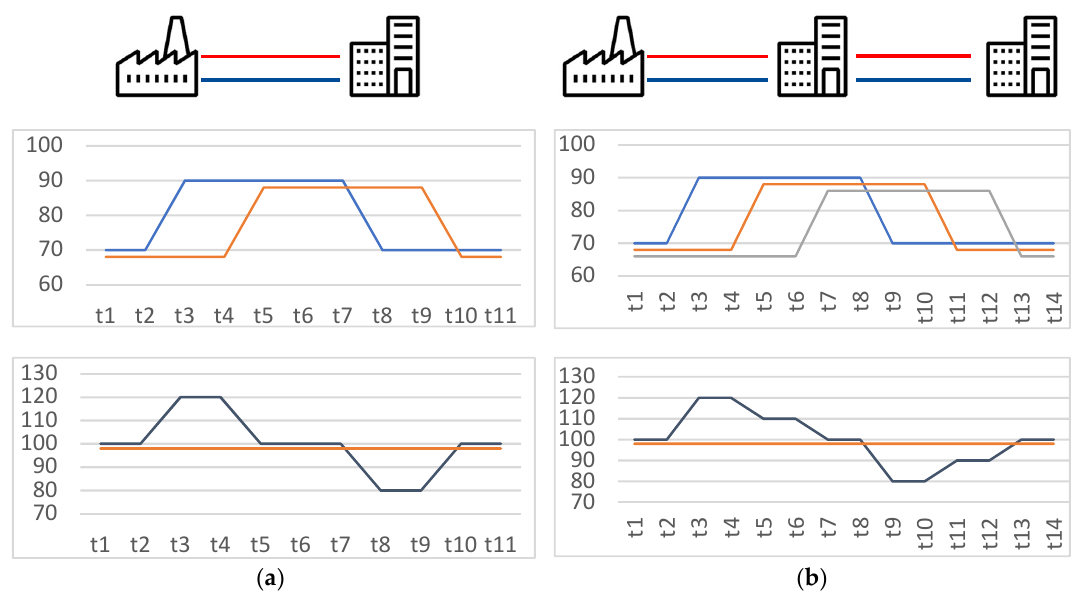
Figure 1. Storage behavior of a heating grid over time for ( a ) one consumers; ( b ) two consumers with constant load. Upper graphs: supply temperature at producer (blue) and at consumer (orange, gray) in °C. Lower graphs: heat output of producer (black) and sum of load of consumers (orange) in MW.